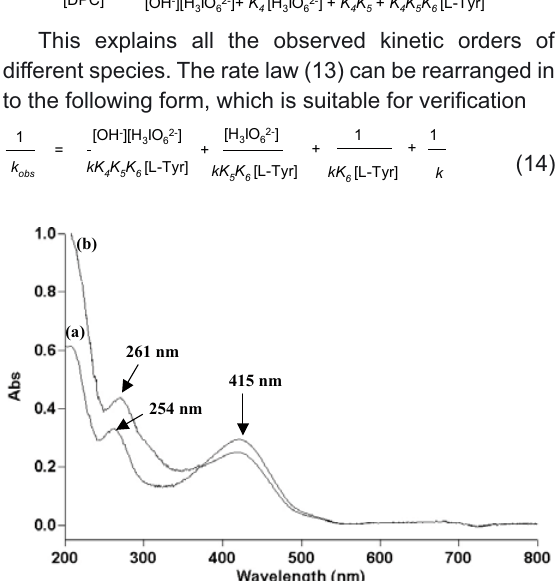
Figure 6. Spectroscopic evidence for the complex formation between DPC and L-Tyr. (a) UV-vis spectra of DPC (254 nm); (b) UV-vis spectra of mixture of DPC and L-Tyr (261